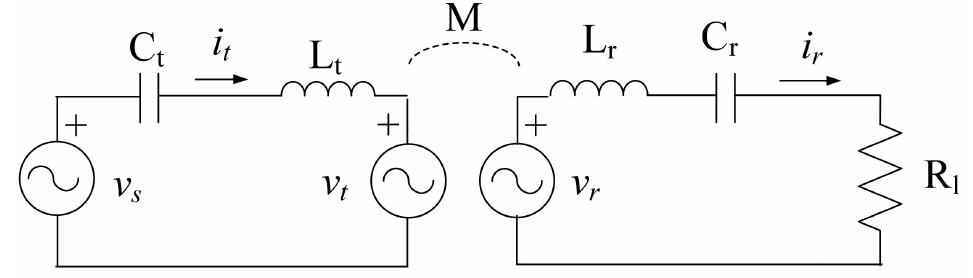
Figure 2. Equivalent circuital diagram of the series-series WPT